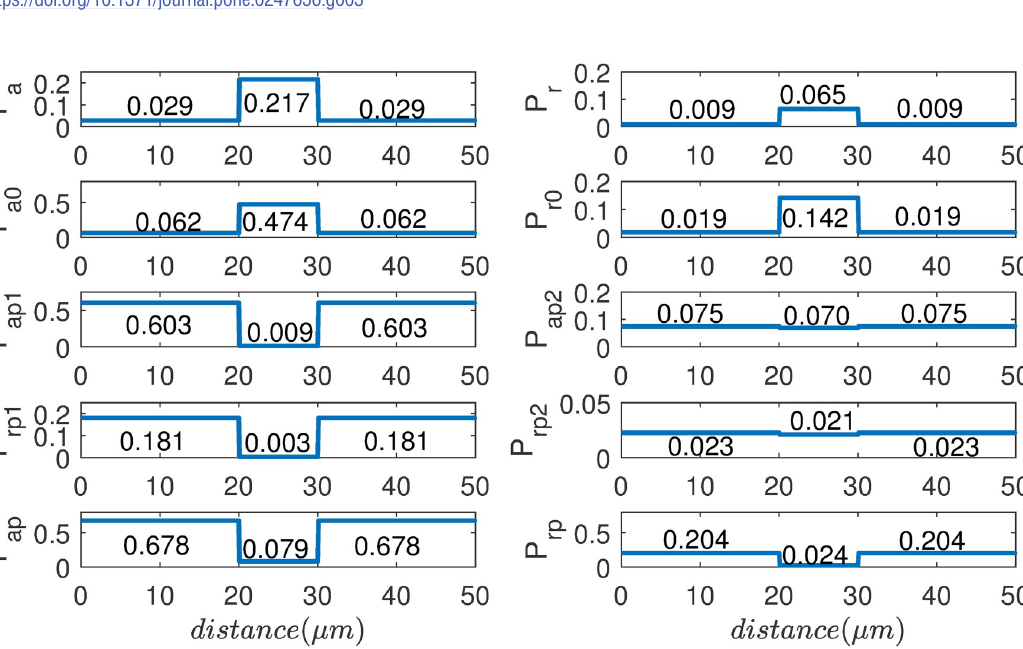
PLOS ONE | https://doi.org/10.1371/journal.pone.0247656 March 12,